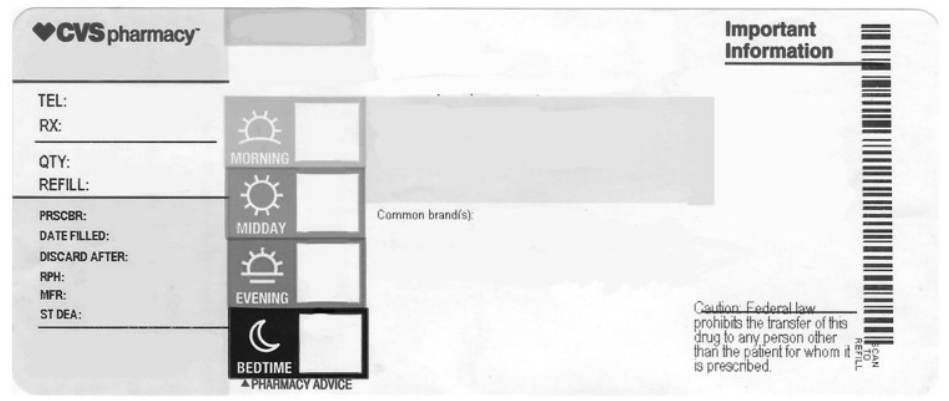
Figure 7. CVS label template.